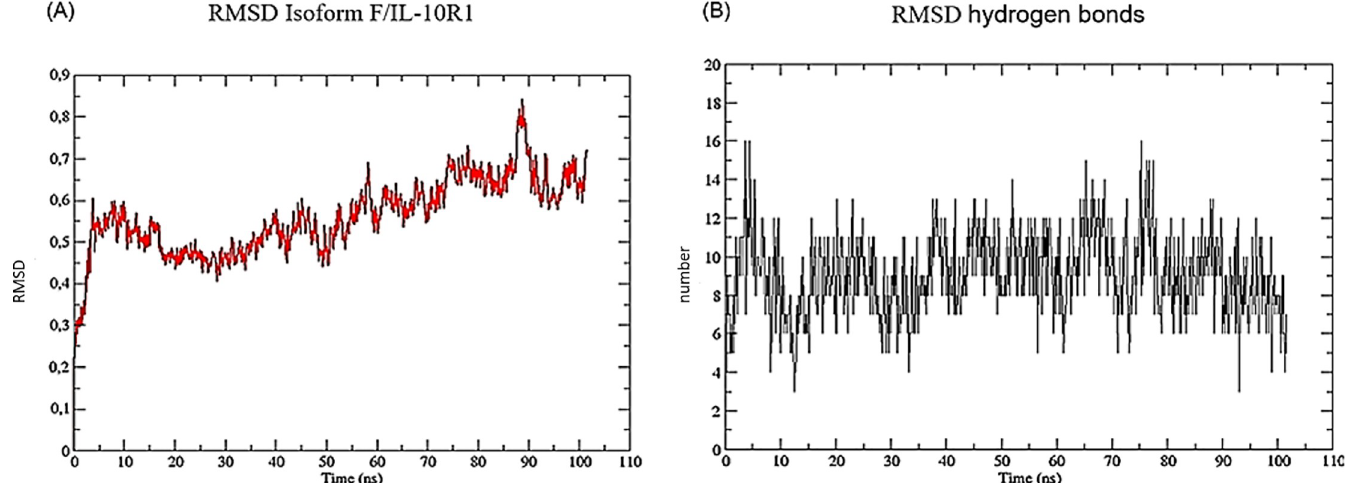
Fig 5. Stability of the complex formed by isoform F and IL-10R1. (A) Stability of the complex formed by isoform F and IL-10R1, according to the root mean square fluctuation (RMSD) values. (B) The stability of the hydrogen bonds of the complex formed by isoform F and IL-10R1.